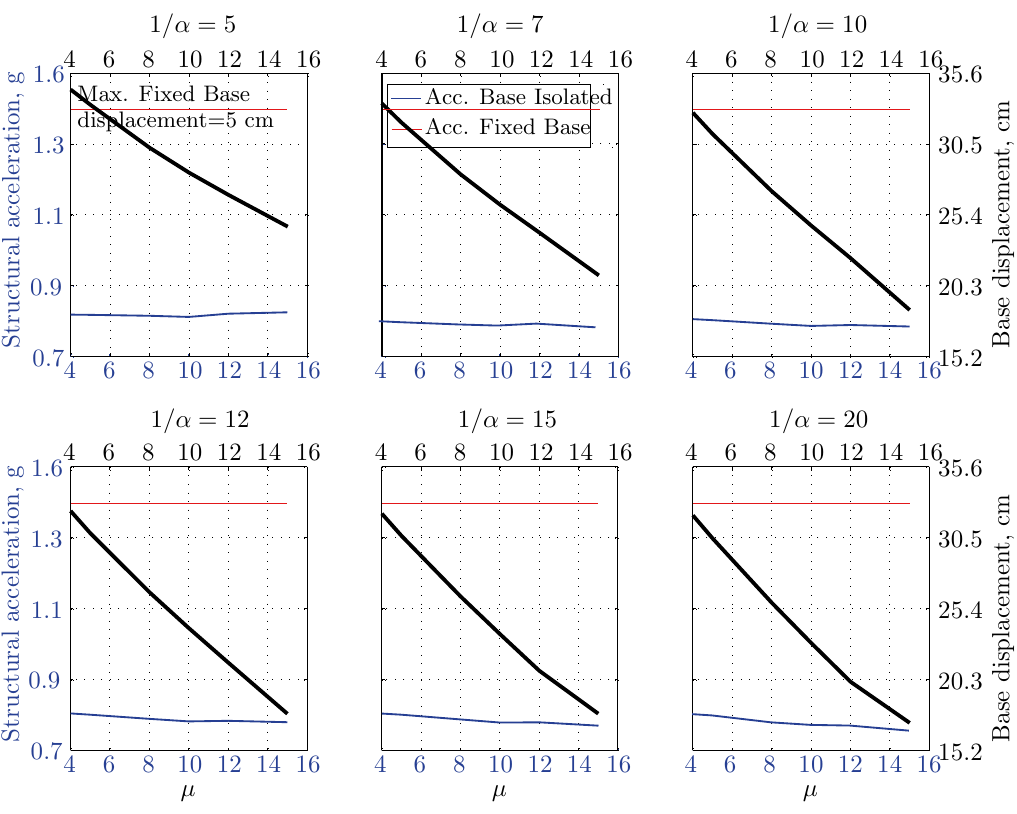
Figure 30. Peak responses of BI-structures subjected Northridge 1994 (Newhall